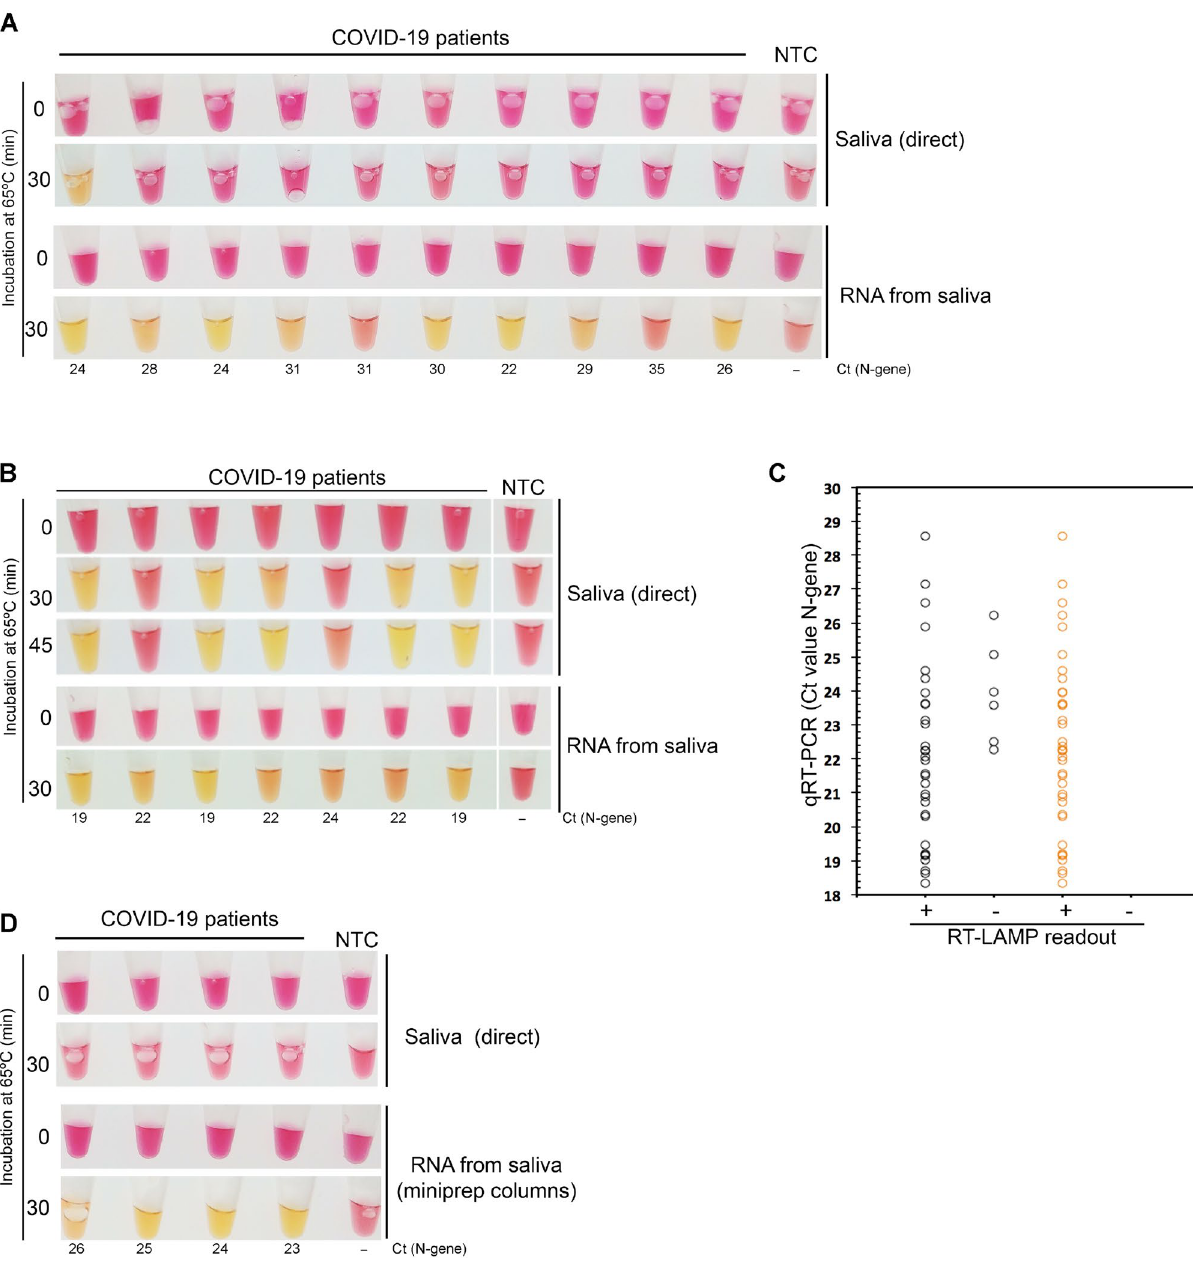
of false negatives. Corroborating this idea, for all other positive samples where salivation was not induced, we obtained a good correlation with the RT-PCR results (Fig. 4B,C), as 33 out of 39 samples were identified as posi- tive samples, with no false positives registered. Therefore, the direct RT-LAMP assay had a sensitivity of 85%